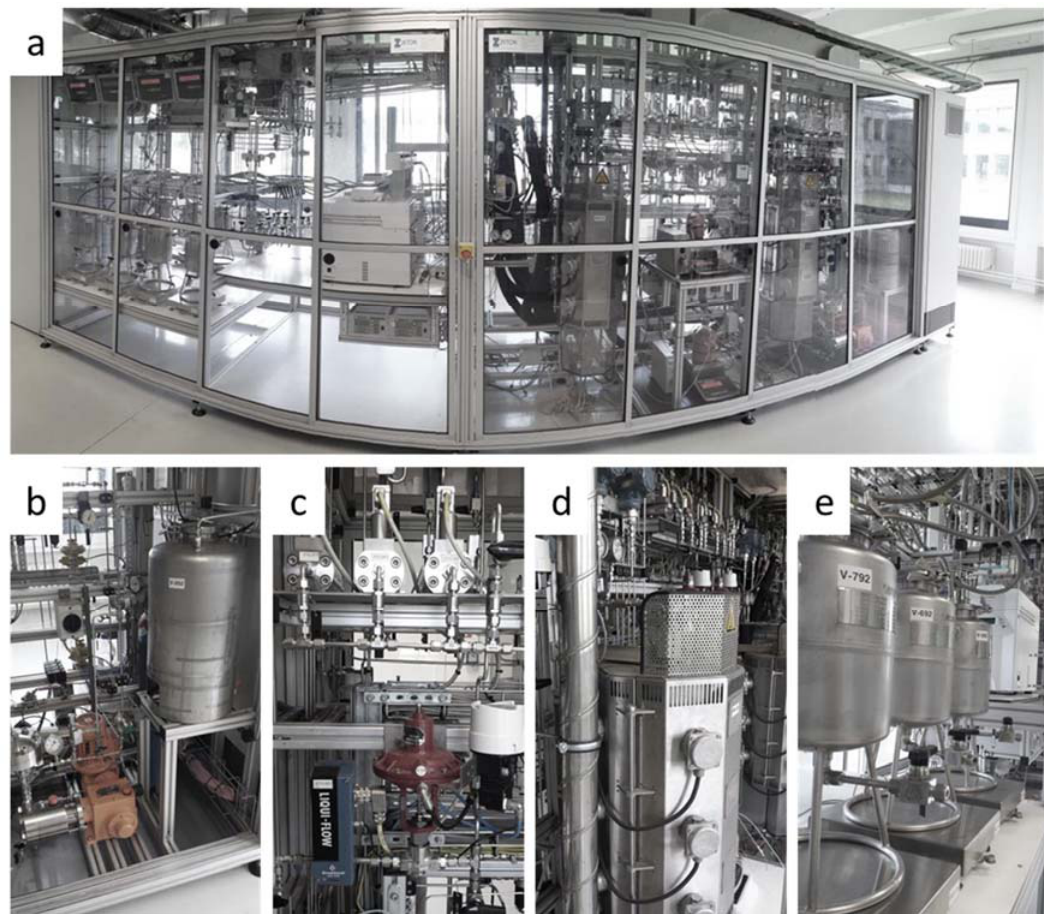
Figure 5. HTK-MI set-up pictures: ( a ) front view; ( b ) liquid pump section; ( c ) gas ( top ) and liquid ( bottom ) feed section; ( d ) reactor blocks; and ( e ) liquid waste